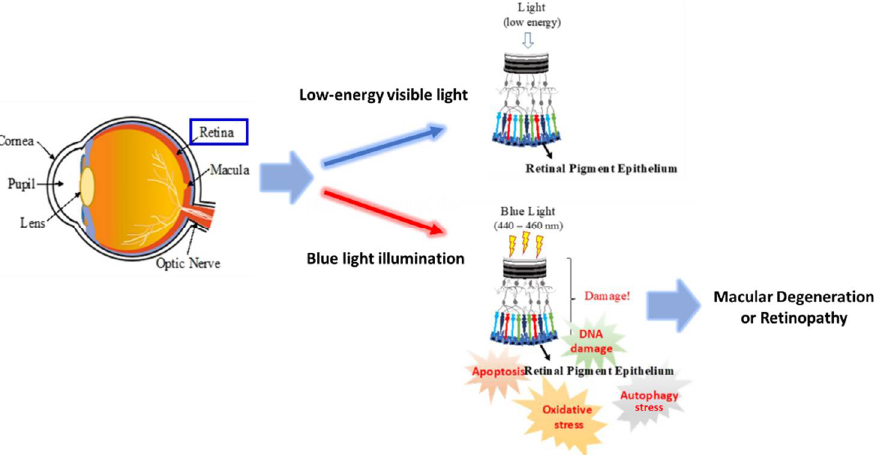
Figure 7. Schematic illustration of blue-light-induced pathogenesis of retinal tissue. Our results suggest that blue light induced a sequential effect in RPE cells, including (1) ROS generation, (2) DNA damage, (3) autophagic stress, and (4) apoptosis, eventually resulting in macular degeneration or retinopathy. The blue arrow indicates low energy visible light which is non-harmful to RPE and the red arrow indicates the illumination of high-energy blue light.